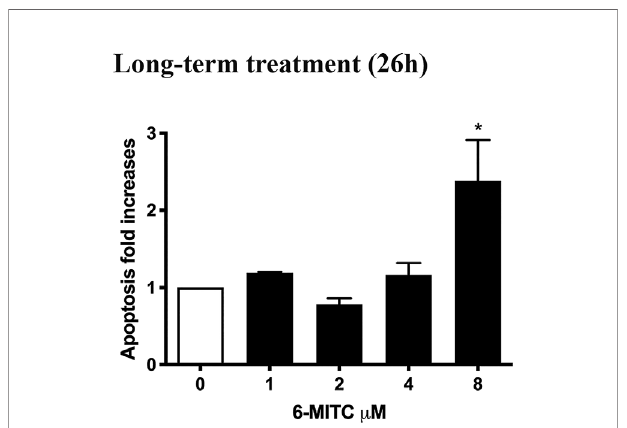
FIGURE 6 | Effect of 6-MITC on apoptosis after long term treatment. Apoptosis fold increase in TK6 cells treated with 6-MITC for 26h. Each bar represents the